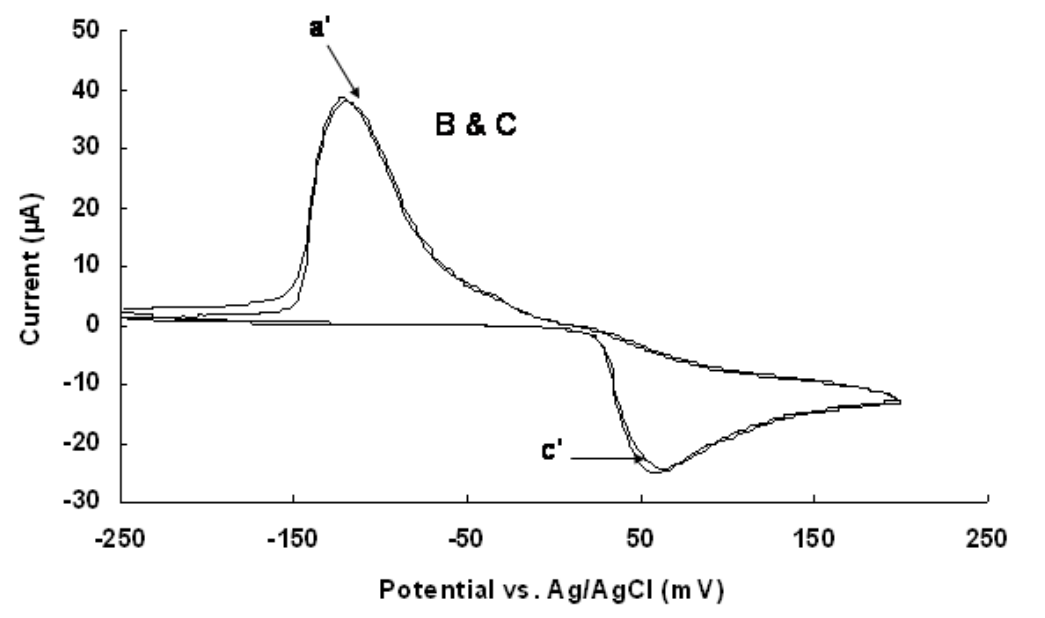
Figure 7. Cyclic voltammograms of silver electrode in a solution of 0.1 M KNO bromide ions and 20 µM albumin (C) 300 µM bromide ions and 30 µM albumin. (a') and (c')